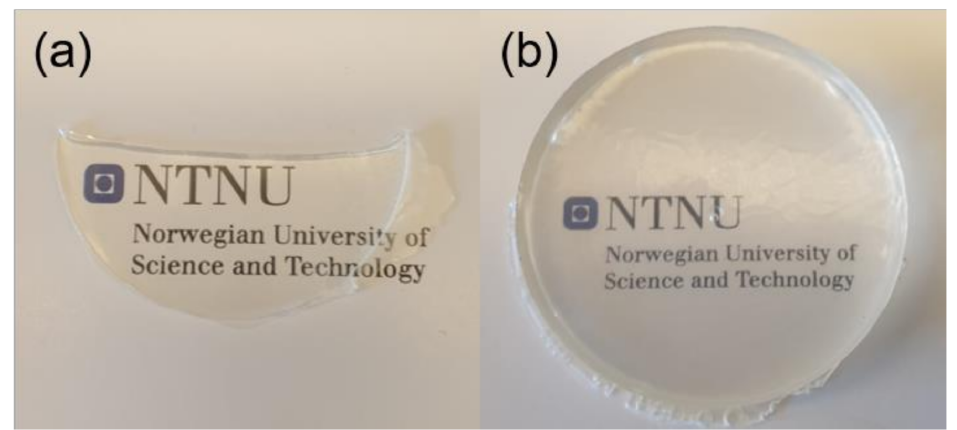
Figure 1. Representative images of transparent epoxy-SiO 2 nanocomposites (5 wt.% SiO 2 with APTES at pH 11) after casting. ( a ) A 1 mm thick sample casted under N 2 pressurization. ( b ) A thick sample (>5 mm) casted without N 2